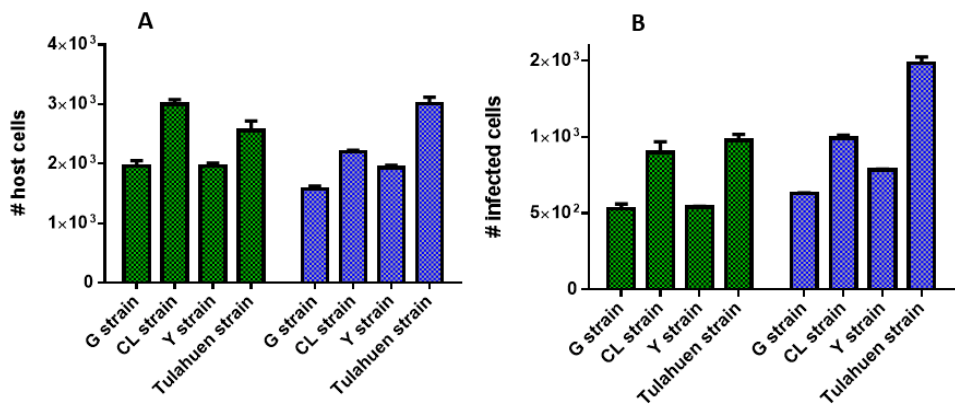
Figure 5. The number of host cells/well ( A ) and number of infected cells/well ( B ) following 48 h (green bars) and 72 h incubation (blue bars) with T. cruzi G, CL, Y and G strain parasites, respectively. Data taken from images acquired on a Phenix imaging system (PerkinElmer) and analysed using Harmony